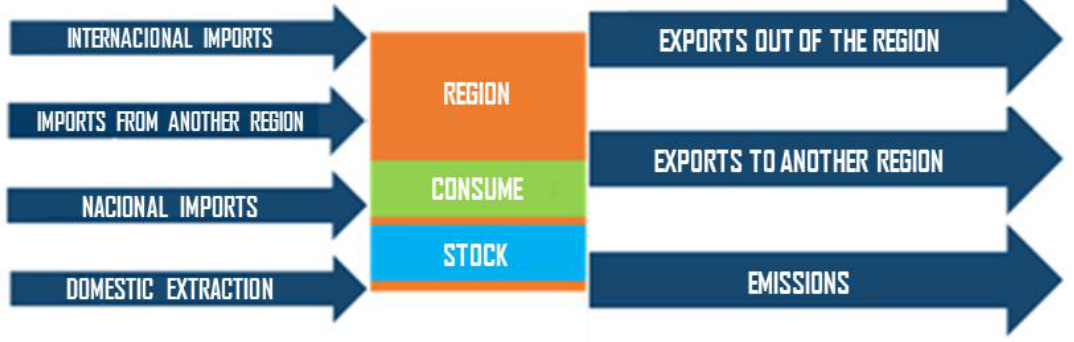
Figure 2. Conceptual scheme of material flows considered in the REMET-UA model [23].